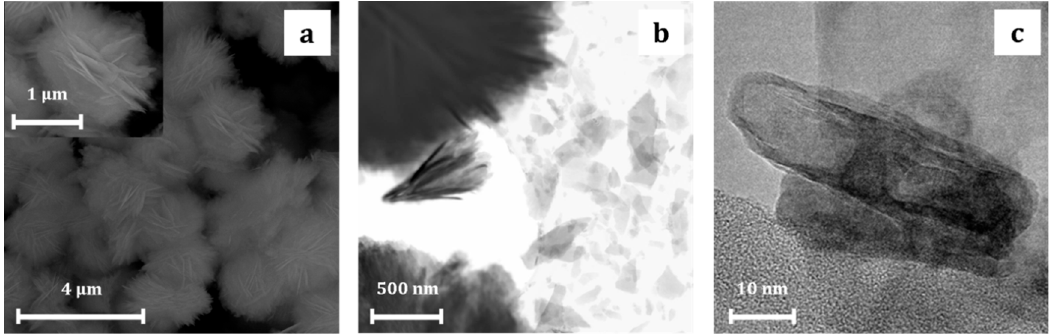
Figure 3. SEM ( a ) and TEM ( b , c ) micrographs of Zn-Carb particles obtained in typical